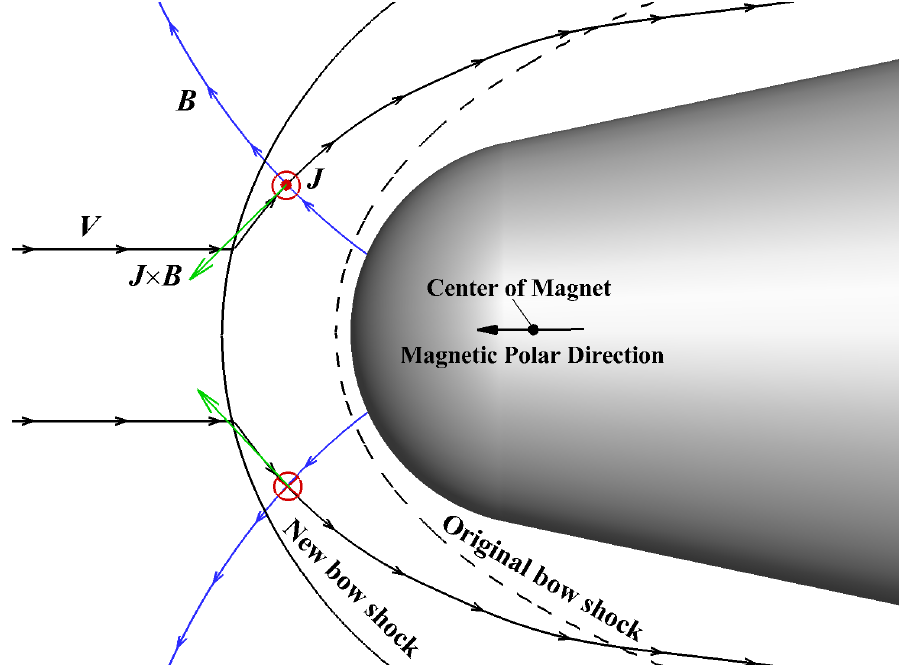
Figure 1. Diagram view of magnetohydrodynamics (MHD) flow